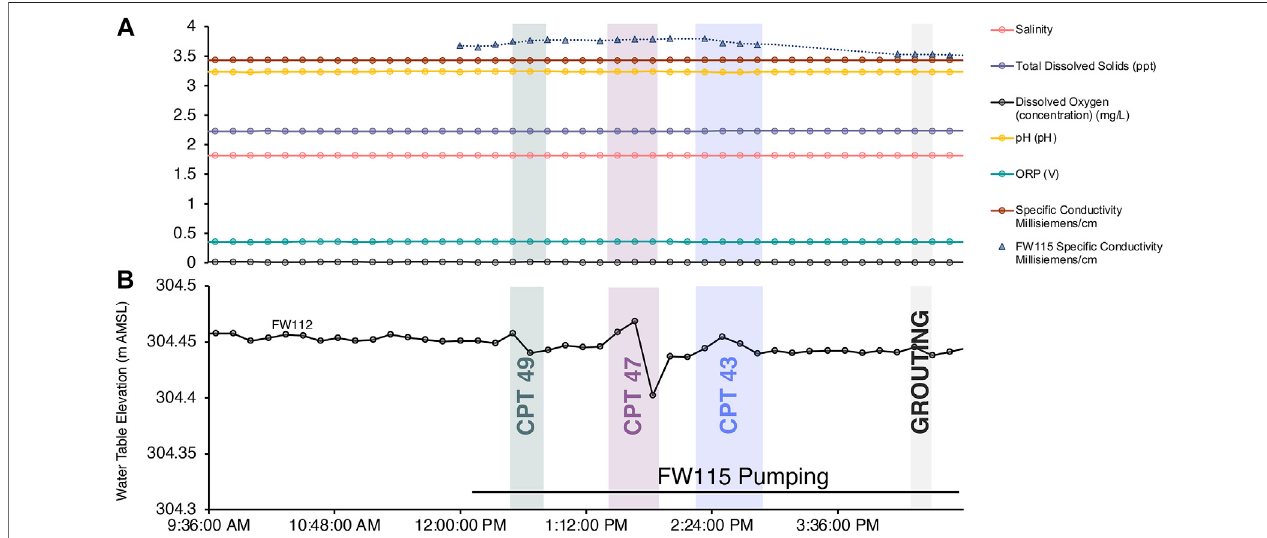
FIGURE5| Effectsofday 8CPTpushesongeochemistryandwaterlevel. (A) showsstablegeochemistryfromthecontinuousmonitoringinFW106(roundpoints) while the shallow speci fi c conductivity in FW115 (triangles) increased during penetration. (B) the advancement and retraction of the probes caused water level changes measurable by the 10 min interval data collected in FW112.